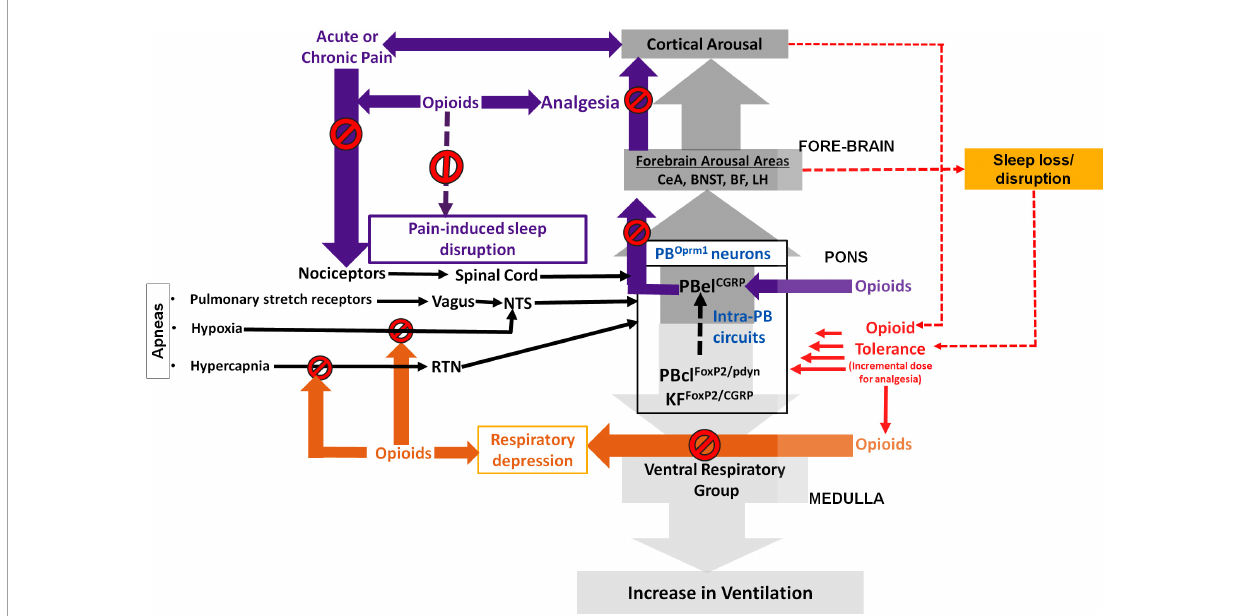
FIGURE1 Schematic showing the possible role of the parabrachial µ -opioid receptor (MOR) expressing neurons (PB Oprm1 ) in regulating opioid induced respiratory depression (OIRD), analgesia, and sleep: The neurons in the centro lateral sub-nucleus of parabrachial area (PBcl) and Kölliker Fu´se (KF) that express FoxP2 (PBcl FoxP2 ) and those that express pro-dynorphin (PBcl pdyn ) may critically modulate respiration through their descending projections to the medullary ventral respiratory group (VRG). Opioids at incrementally higher dose (due to developing opioid tolerance) may act by inhibiting the PBcl FoxP2 /PBcl pdyn neurons resulting in a continuous cycle of progressively depressed respiration that can prove to be fatal. Both hypercapnia and hypoxia stimuli (during apneic events) are conveyed to the PB via the retrotrapezoid (RTN) and nucleus of solitary tract (NTS), and these pathways are also inhibited by opioids use and tolerance. The interconnectivity of the PB Oprm1 neurons, specifically between the PBcl FoxP2 /PBcl pdyn and PBel CGRP subpopulations may explain cortical arousal that results from respiratory stress during sleep apnea. The PB neurons that express CGRP (PBel CGRP ) regulate waking up in response to pain, hypercapnia and aversive stimuli through their projections to the forebrain arousal areas such as, central nucleus of amygdala (CeA); the bed nucleus of stria terminalis (BNST); the basal forebrain (BF) and the lateral hypothalamus (LH). Opioids may provide analgesia and prevent sleep disruption (SD) by inhibiting the PBel CGRP neurons that act as relay node for the pain stimulus which is transmitted to these neurons via the spinal cord. In contrast, inadequate sleep over-activate this cortical arousal circuit, inclusive of the PBel CGRP neurons, which causes decreased sensitivity to inhibition from opioids, also known as opioid tolerance. Sleep disruption, in itself, also cause increased pain sensitivity, with decreasing levels of opioid induced analgesia. The resulting continuous cycle accelerates opioid tolerance while progressively reducing opioid